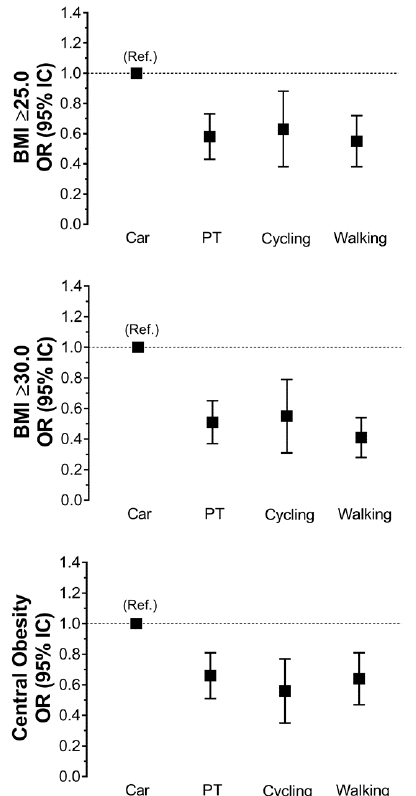
Figure 2. Association between travel mode and obesity outcomes. Data presented as odds ratio and their 95% confidence intervals. Car travellers were used as a reference. Analyses were adjusted by socio-demographic factors (age, sex, education and place of residency), lifestyle factors (smoking, alcohol, fruit and vegetable intake and sedentary behaviours) and leisure PA. WC: waist circumference; β: beta coefficient. Central obesity was defined as WC >88 and >102 cm for men and women, respectively.